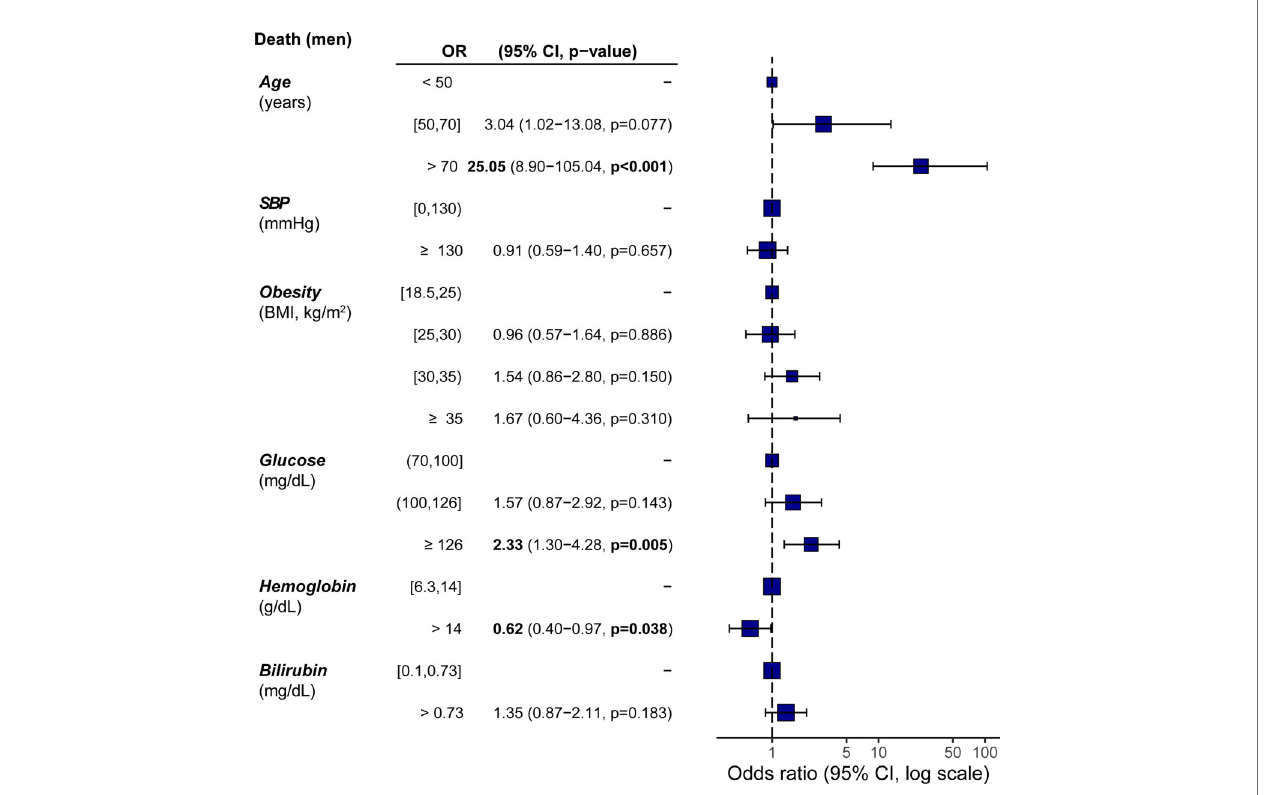
FIGURE 4 | Incidence odds ratio of mortality from COVID-19 in men including iron-related parameters as prognostic variables. Data are presented as odds ratio (OR) and 95% con fi dence intervals (CI). The reference groups (OR=1) for each variable are shown as “ - ” .: The odds ratios shown are adjusted through a logistic regression model which includes all variables listed. Data are also represented as a forest plot. Hemoglobin and bilirubin were dichotomized based on the median